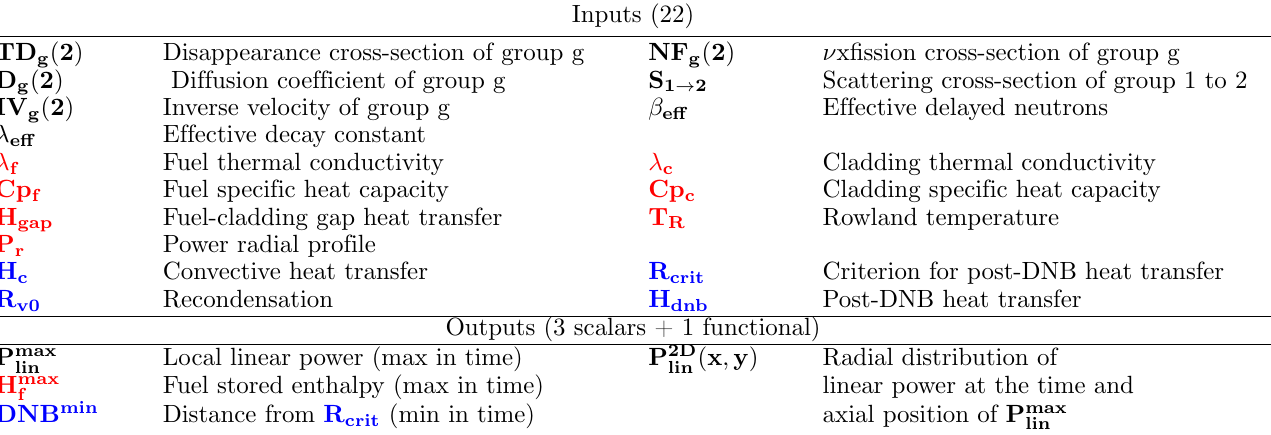
Table 3. Inputs and outputs identification by discipline: neutronics , fuel-thermal and thermal-hydraulics . Inputs